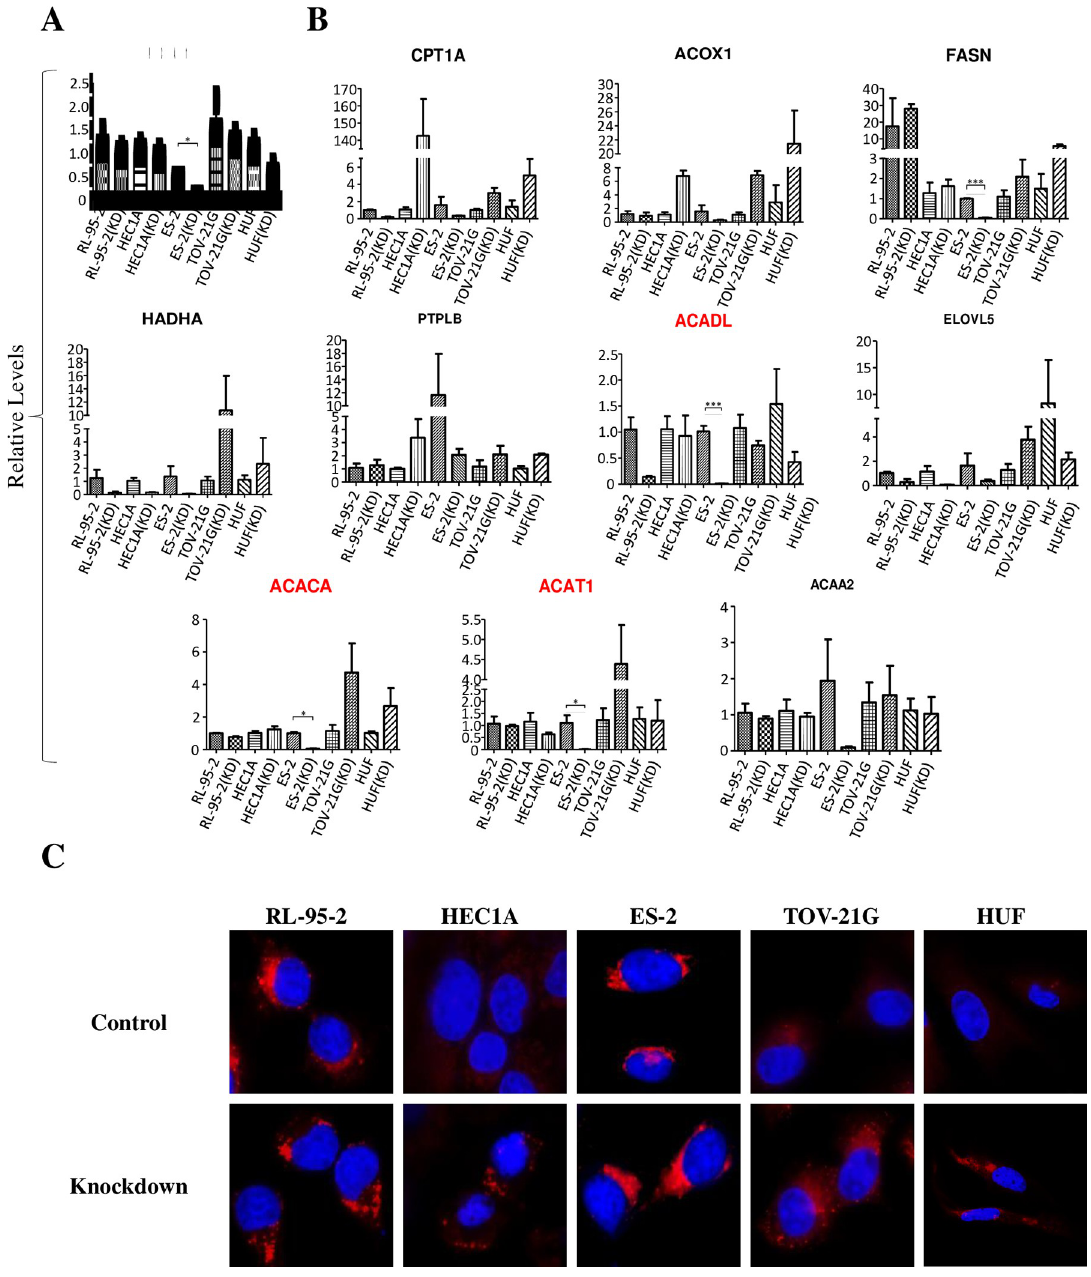
Fig 7. Functional impacts of UCA1 knockdown on fatty acid metabolism in endometrial cells. ( A ) UCA1 knockdown in different endometrial cell lines (RL-95-2, HEC1A, ES-2, TOV-21G, and HUF). ( B ) Relative gene expression levels of key genes in fatty acid metabolism (CPT1A, ACOX1, FASN, HADHA, ACADL, ELOVL5, ACACA, ACAT1, PTPLB, ACAA2) were detected by RT-qPCR in UCA1-knockdown and control cells. ( C ) Lipid droplet staining in treated cells was performed by using